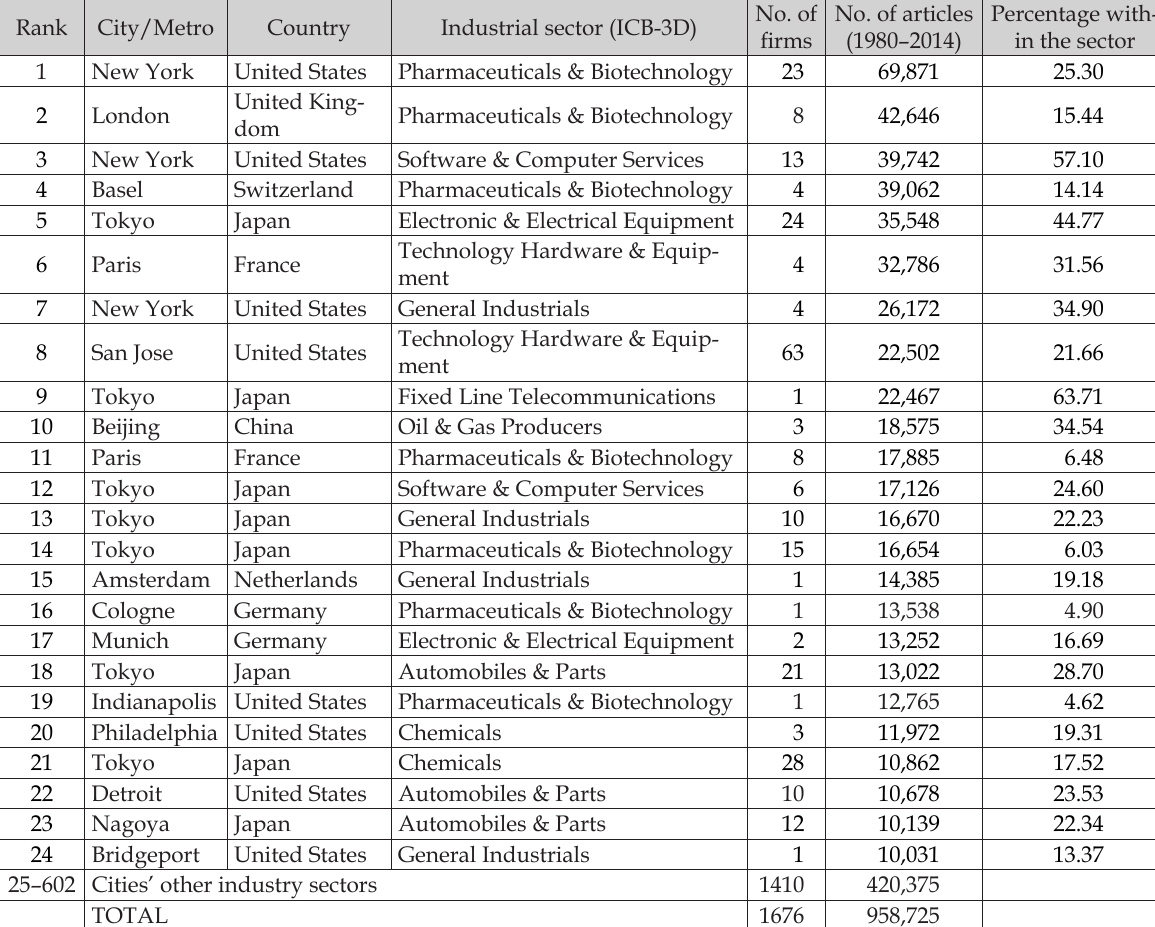
Table 2. Ranking industry sectors in cities by the number of scientific articles published by